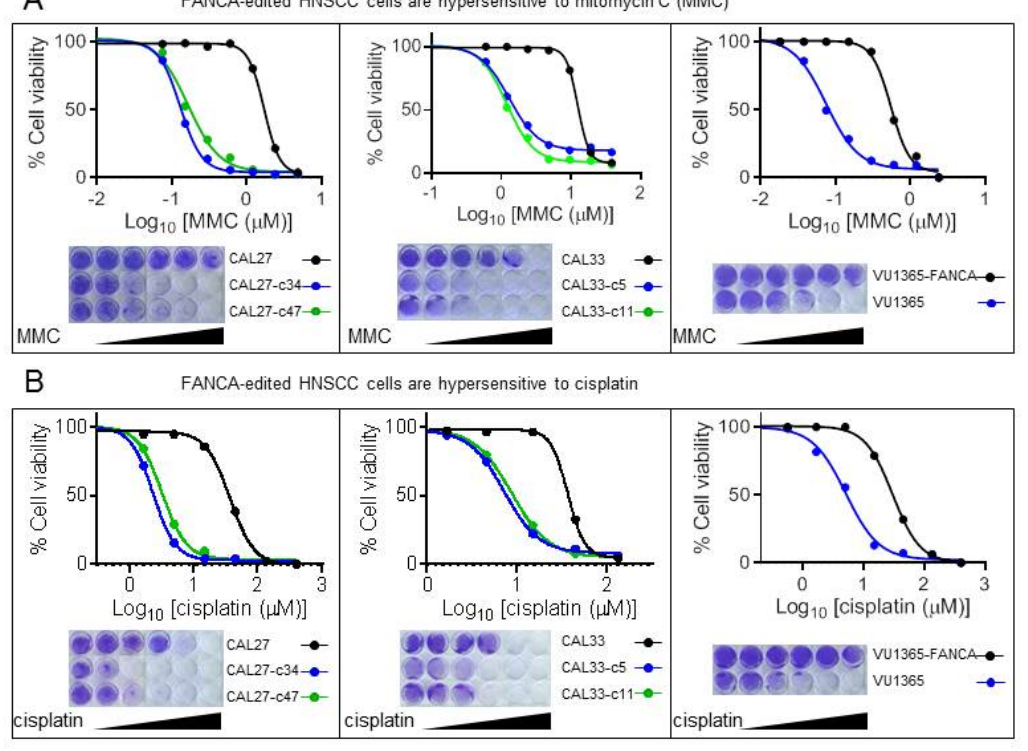
Figure 2. FANCA -edited HNSCC cells are hypersensitive to ICL agents. Cells were treated with increasing concentrations of mitomycin C (MMC) ( A ) or cisplatin ( B ) for 1 h and grown until control cells reached the maximum confluence (5 days). Cells were stained with crystal violet, eluted with acetic acid, and color intensity was measured with absorbance at 620 nm. Data represent means ± SEMs from three different experiments for each cell line. FANCA -mutant CAL27 and CAL33 edited clones are more sensitive than parental cells to MMC and cisplatin insults. As expected, VU1365 cancer cells from an FA patient are also more sensitive than FANCA -complemented, VU1365-FANCA cells. Table 1. Half-maximal inhibitory concentration (IC50) values for mitomycin C (MMC) and cisplatin (microM). Cell Line